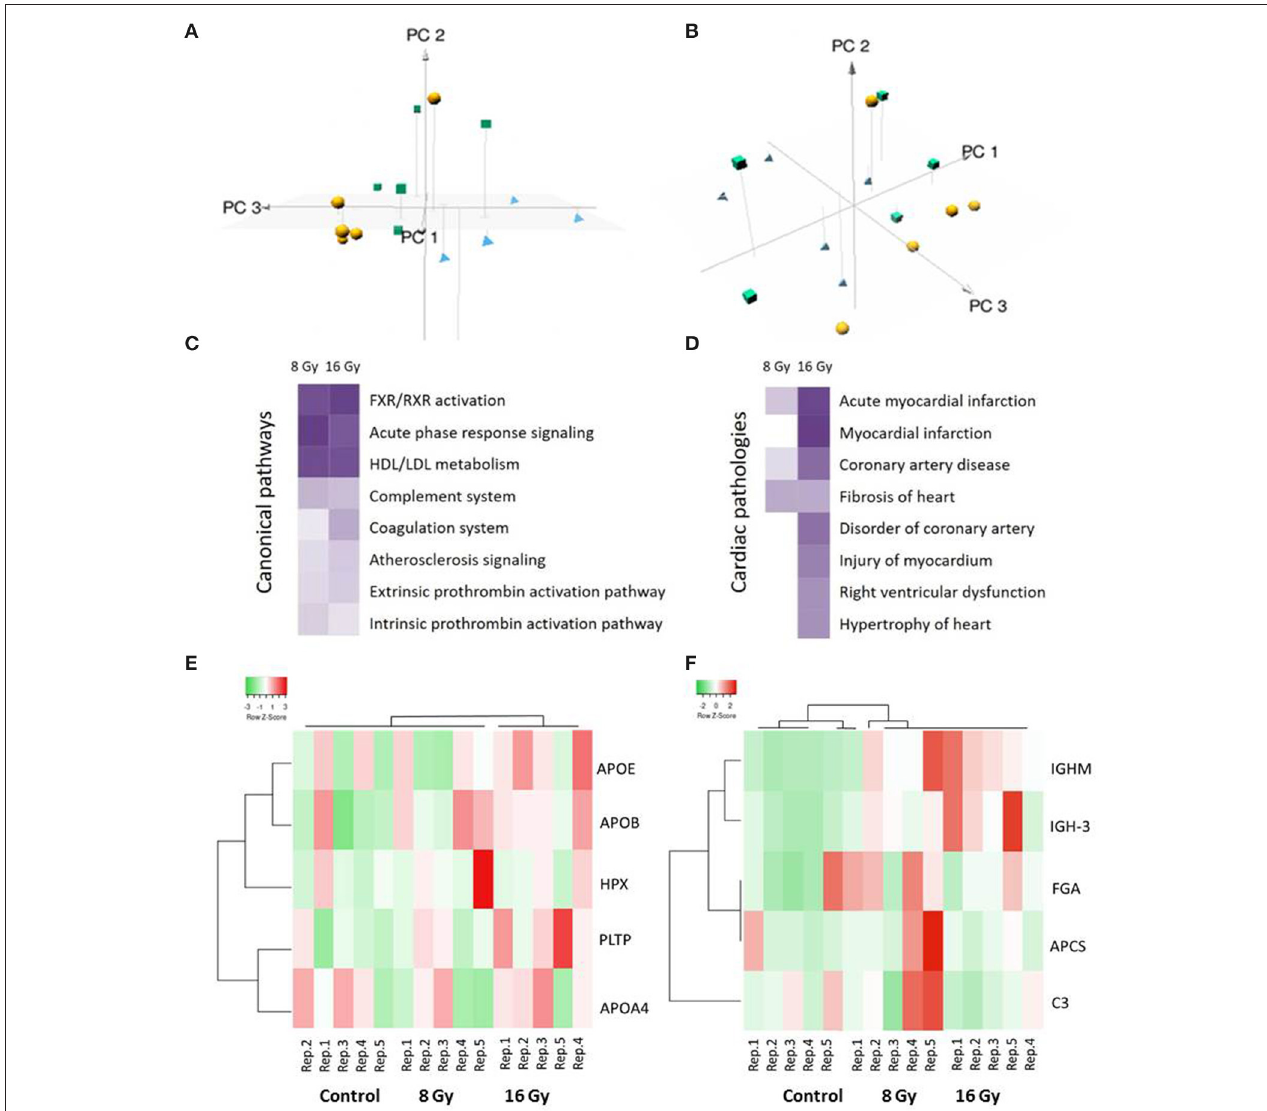
FIGURE 1 | Multivariate, pathway, and cardiotoxicity analyses of the significantly differentially expressed serum proteins after local heart irradiation using 0 (control), 8, or 16Gy. The principal component analysis (PCA) performed on normalized intensities of all proteins resulted in PC1, PC2, and PC3 as follows: PC1 15.9%, PC2 15.1%, and PC3 12.3%. The control samples are represented as yellow balls, the samples exposed to 8Gy in green cubes, and the 16Gy treated samples in blue pyramids (A,B) . A dose-dependent alteration is observed in the pathways involved in the inflammation and lipid metabolism (C) . Several proteins were identified associated with different heart pathologies (D) . The pathway and cardiotoxicity scores are displayed using a purple color gradient; the darker the color, the higher the scores and, thereby, statistical significance. The score is the negative log of the p -value derived from the Fisher’s Exact test. By default, the rows (pathways) with the highest total scores across the set of observations are sorted to the top. The analysis was performed using Ingenuity Pathway Analysis (IPA) (Qiagen Inc., https://www. qiagenbioinformatics.com/products/ingenuity-pathway-analysis). The heat maps show hierarchical clustering (complete linkage, Spearman ranked correlation) of significantly deregulated proteins belonging to the high-density lipoprotein (HDL)/low-density lipoprotein (LDL) metabolism (E) and acute phase response (F) pathways in the control and irradiated samples. The green bars indicate downregulation and the red bars upregulation. The analysis was performed by the Heatmapper web server (http://www.heatmapper.ca/) (31). Detailed information of the proteomics features and individual samples is given in Supplementary Table 1